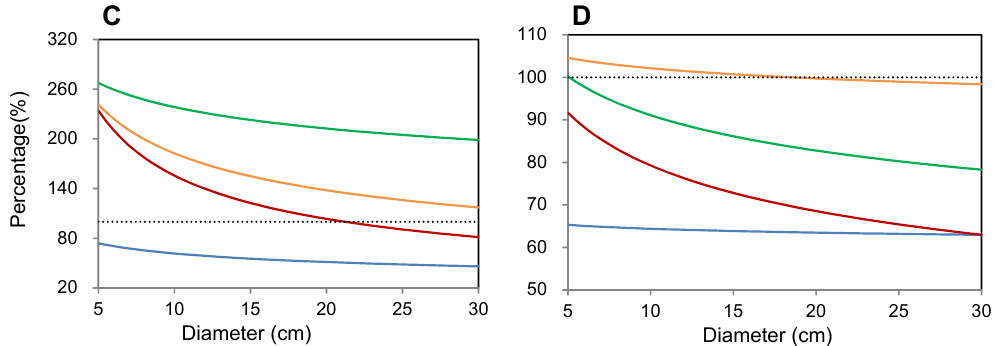
Figure 4. The relationship between the diameter and proportion of calculated biomass of damaged trees